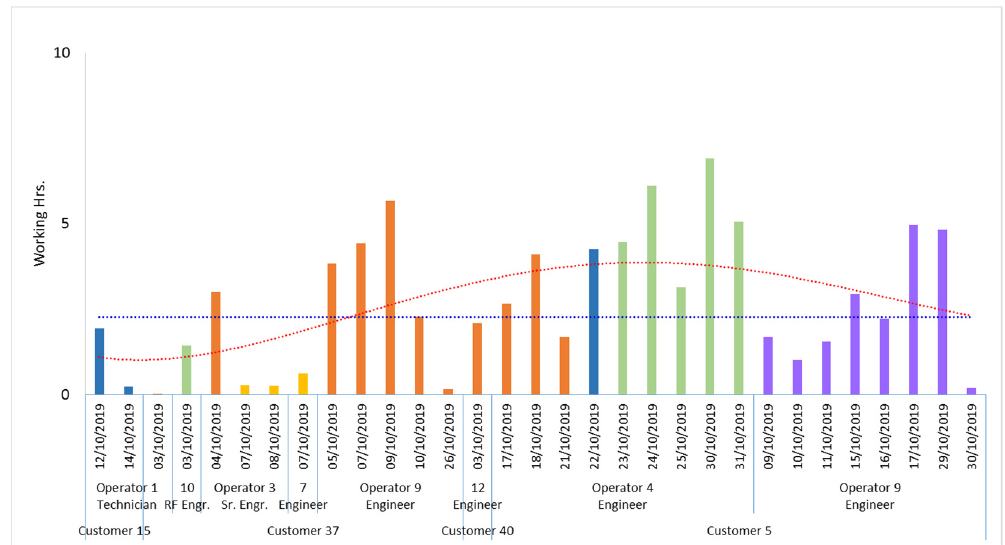
Figure 10. Product type Complex Digital—October 2019.